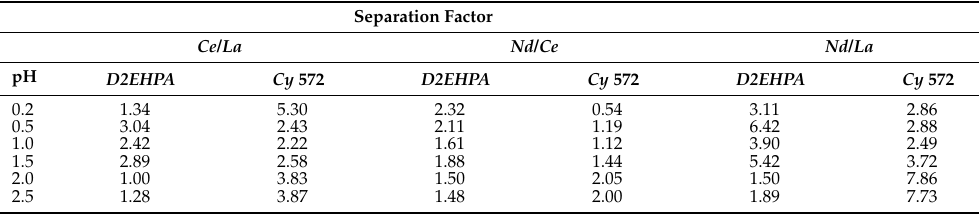
Table 6. Separation factors of Ce , La and Nd with D 2 EHPA and Cyanex 572. Separation